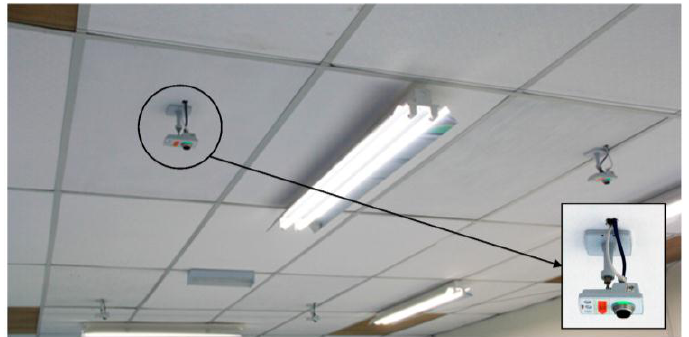
Figure 7. Robot tracking cameras over the test area.